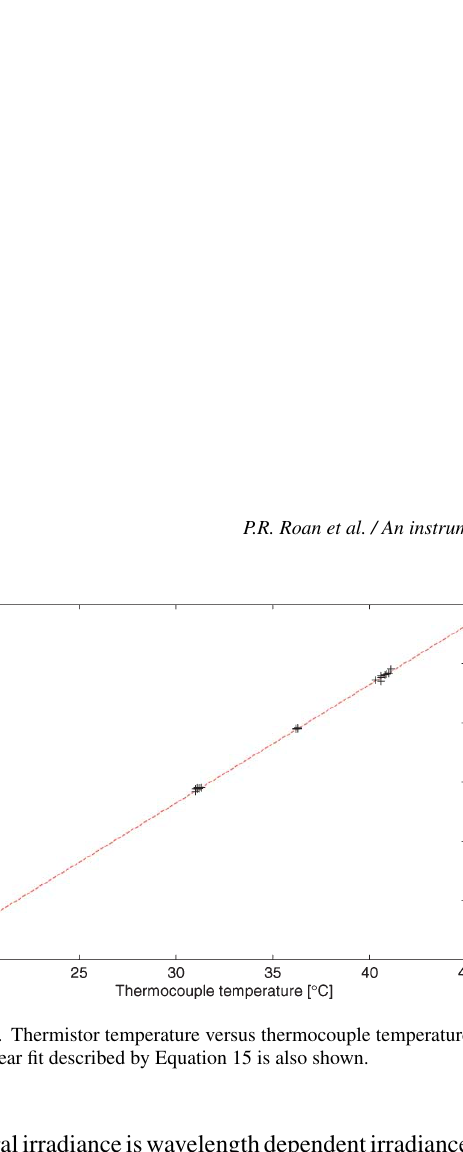
spectral irradiance is wavelength dependent